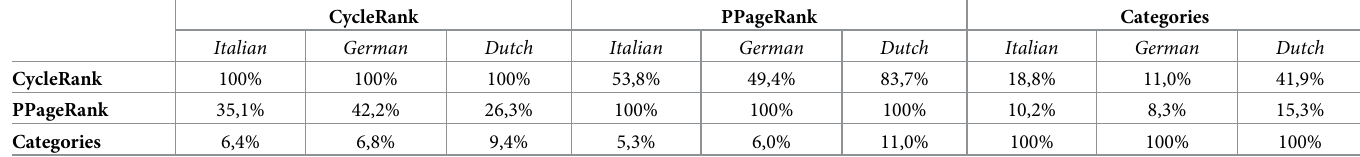
Table 2. Percentages of features shared by each feature set given the method used to extract them. Since the various datasets have different sizes, the percentages are not symmetrical. Each row shows the result for one of the methods. For instance, the CycleRank row shows the fraction of features it shares with the other feature sets. CycleRank PPageRank